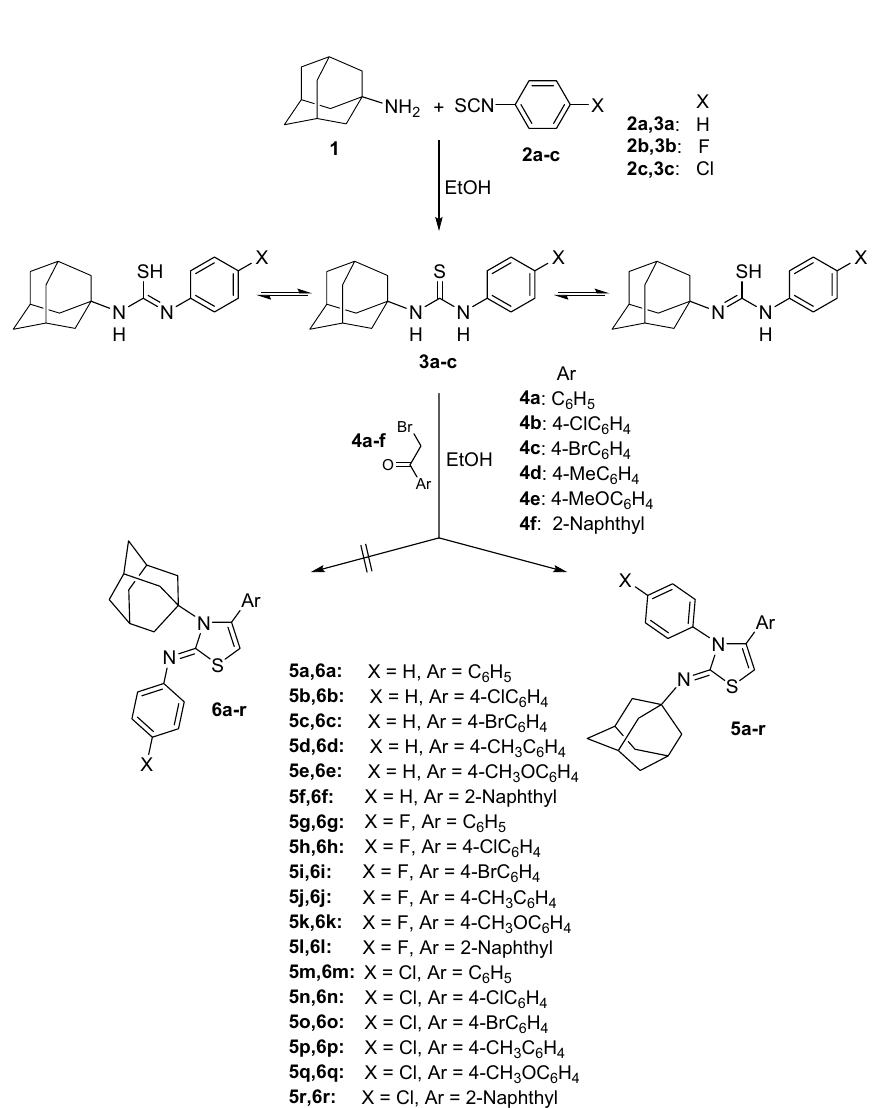
Figure 3. Synthetic outline of the target compounds 5a-r